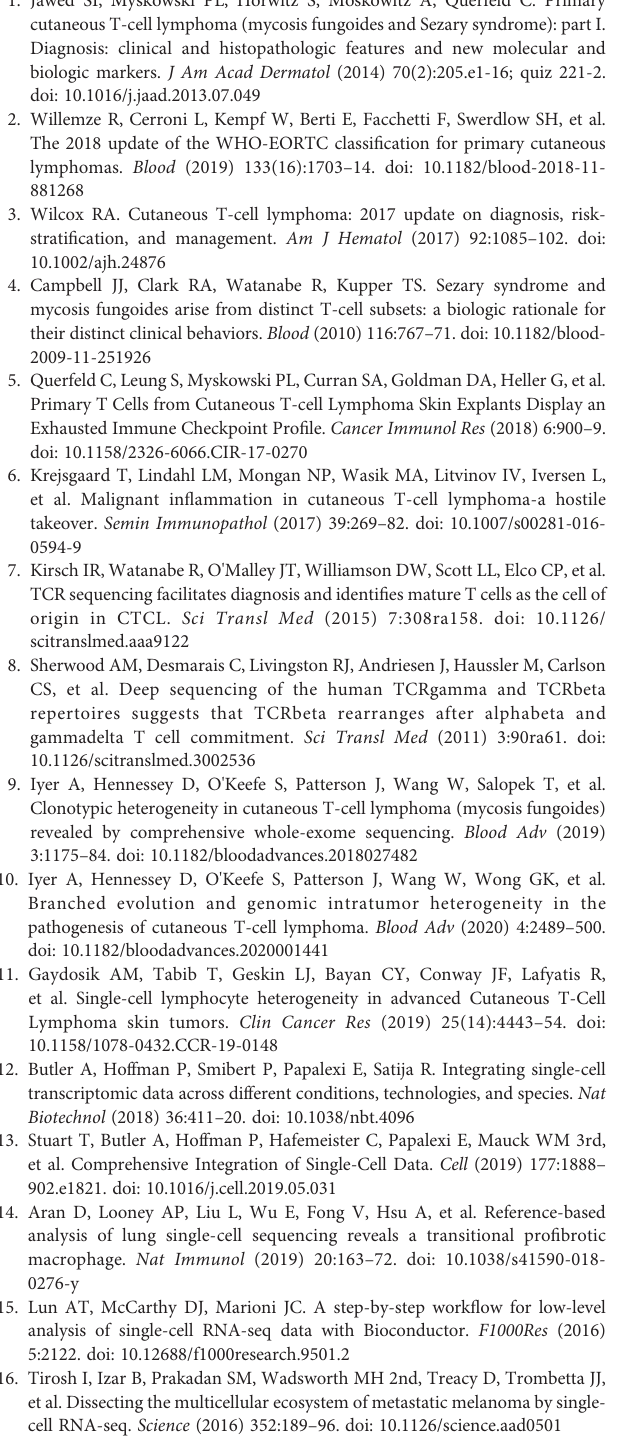
package Monocle. Only genes with a q -value <10 -6 and expressed in more than 10 cells are shown in the table and in Figure 6D (500